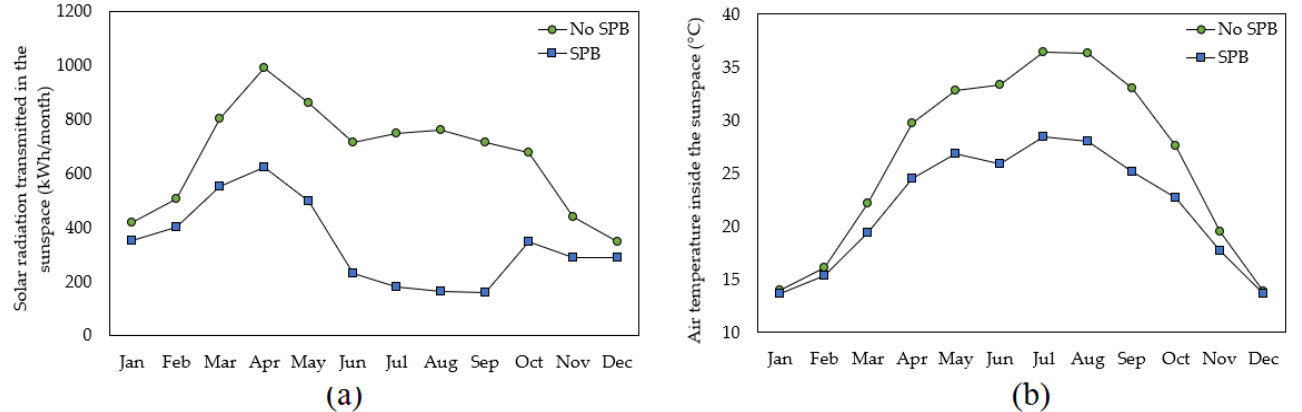
Figure 9. Analysis with and without SPBs: ( a ) Monthly average solar radiation transmitted in the sun space; ( b ) monthly average air temperature inside the sun space.